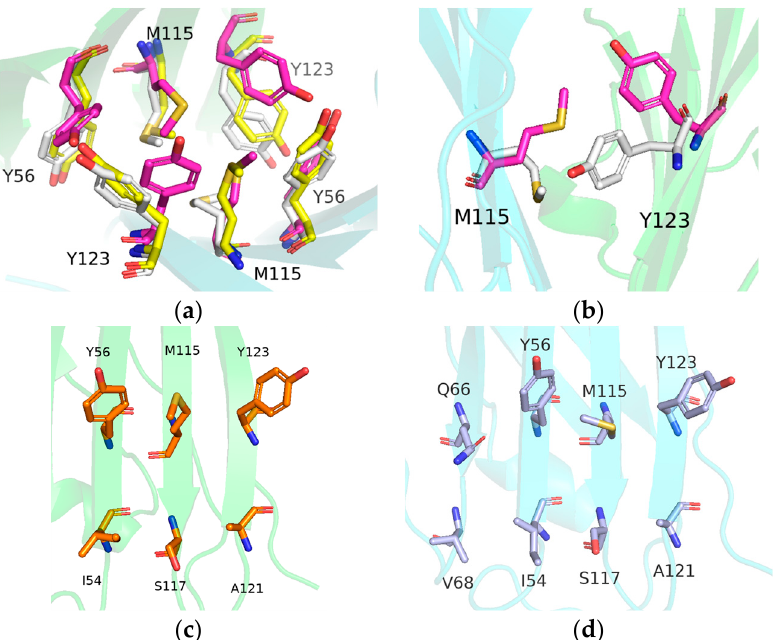
Figure 11. ( a ) Conformational differences among the stable conformation of the MS and Dimer system. ( b ) The entrance of the binding pocket was completely blocked by the conformational changes of residues A Tyr123 and B Met115, resulting in pocket disappearance. In the SA ( c ) and SB ( d ) systems, PD-L1 combined with the inhibitor to form an open conformation in preparation for PD-L1 dimerization. MS, SA, SB, DIM-Conf 1, and DIM-Conf 2 conformation are colored in magenta, orange, light blue, yellow, and white, respectively. A PD-L1 and B PD-L1 are colored in green and cyan, respectively.